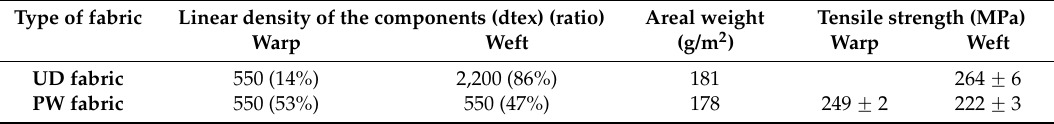
Table 1. Areal weight and mechanical characteristics of the reinforcing structures. Type of fabric Linear density of the components (dtex)